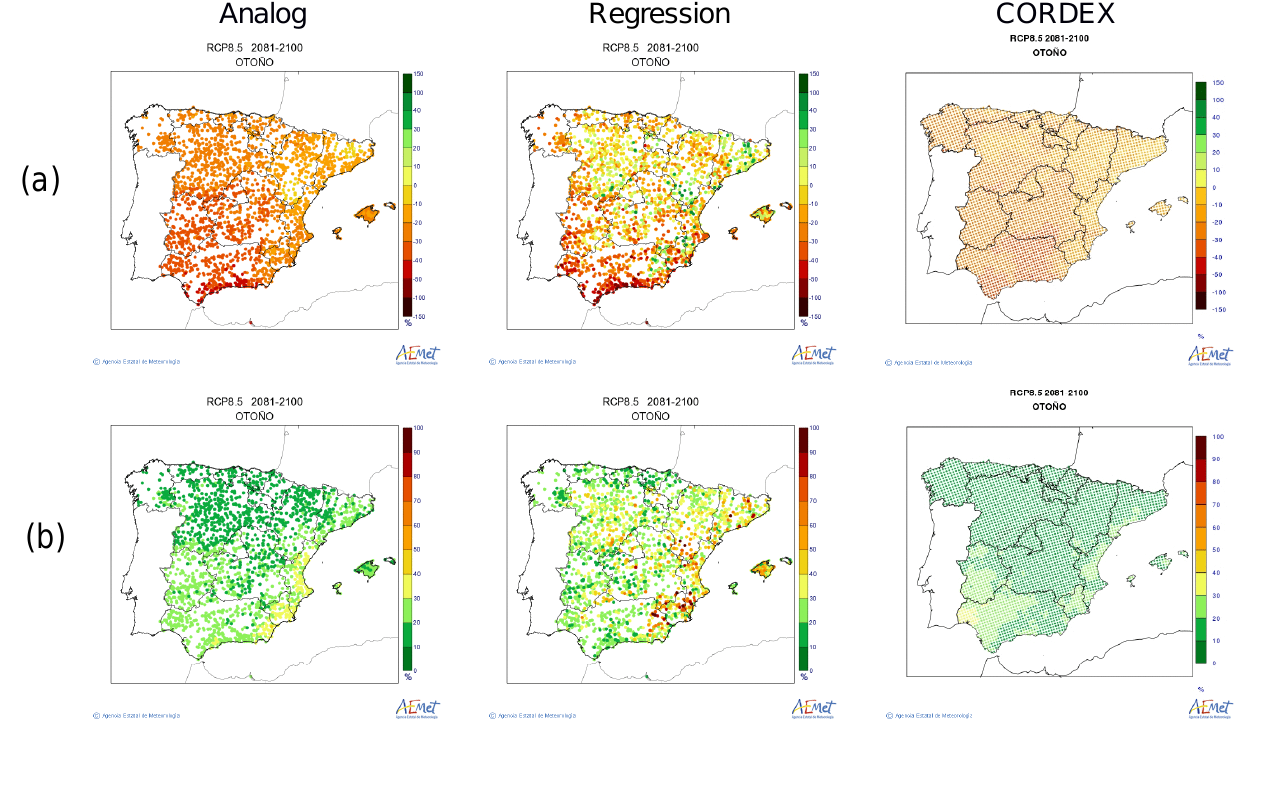
Figure 2. Change of (a) autumn mean precipitation (%) and (b) uncertainty ( ± σ ) for RPC8.5 scenario in the 2081–2100 period with respect to the reference period